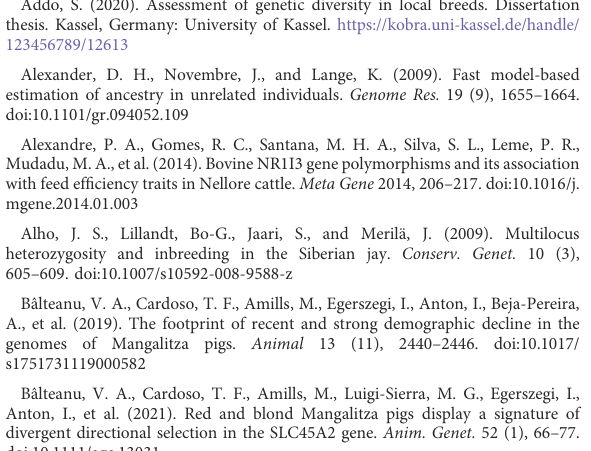
SUPPLEMENTARY FIGURE 1 Cross-validation for varying number of clusters ranging from k = 2 to k = 20 in Mangalitsa pigs. SUPPLEMENTARY FIGURE 2 ROH incidence plots for each chromosome in Blond Mangalitsa pigs. SUPPLEMENTARY FIGURE 3 ROH incidence plots for each chromosome in Red Mangalitsa pigs. SUPPLEMENTARY FIGURE 4 ROH incidence plots for each chromosome in Swallow-bellied Mangalitsa pigs. SUPPLEMENTARY TABLE 1 SNPs in ROH island in Blond (BM), Red (RM) and Swallow-bellied (SM) Mangalitsa pigs. SNP positions were mapped to the Sus scrofa genome version 10.2. SUPPLEMENTARY DATA 1 Plink formatted fi les consisting of Blond (BM), Red (RM) and Swallow- bellied Mangalitsa (SM)